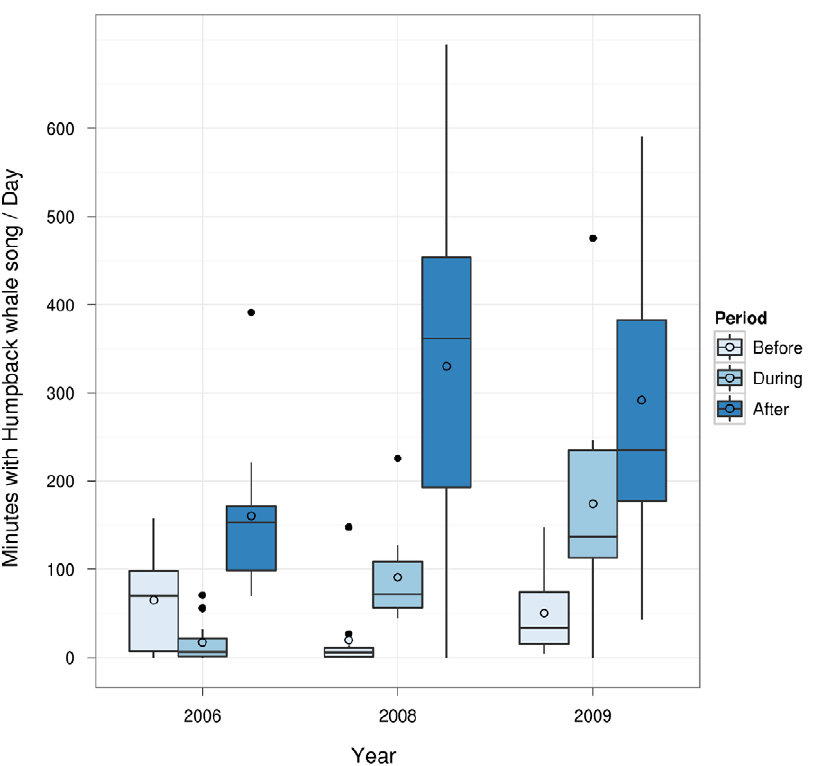
Figure 3. Box-and-Whisker plot of minutes/day containing humpback whale song for 33 days ‘before-during-after’ OAWRS FM pulse transmissions in 2006, and for the same 33 calendar days in 2008 and 2009. Lower and upper bounds of boxes represent lower and upper quartiles, respectively. Solid lines represent medians and non-filled circles are means. Whiskers represent furthest data points within 1.5 6 interquartile range (IQR) of the lower and higher quartile, respectively. Filled dots are